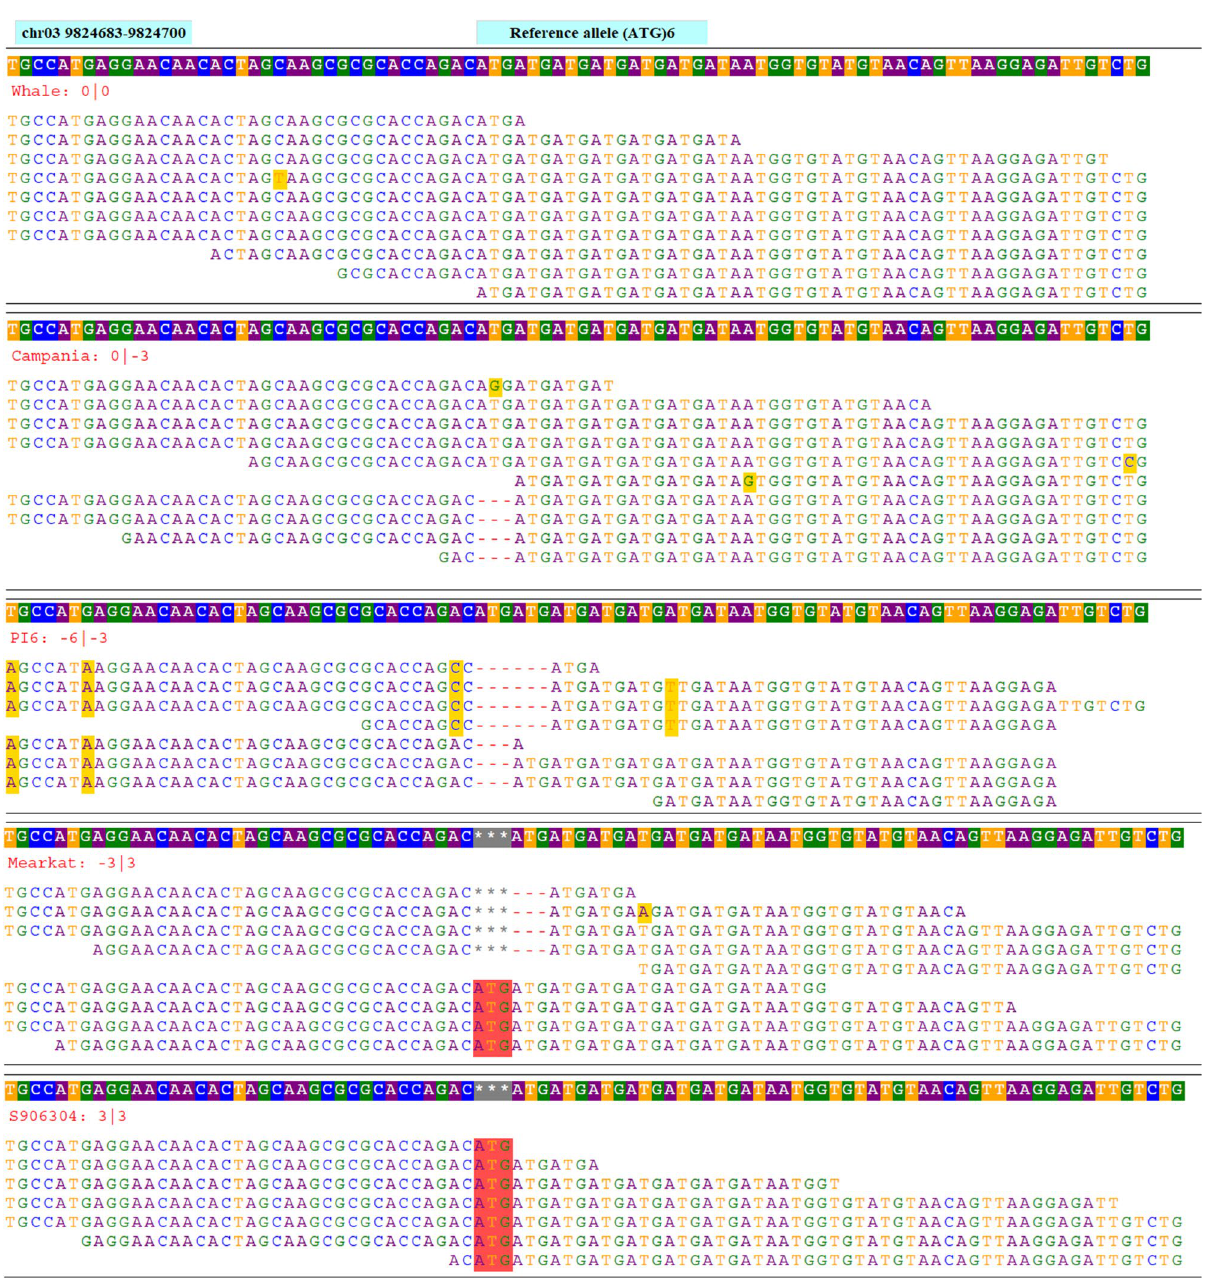
Figure 3. Genome sequences alignments of tri-repeat SSR loci chr03_3_9824683 comprised of ’ATG’ motif repeating for six times (ATG)6 and located on chromosome 3 at 9,824,683 bp in the reference genome. Genome sequences of multiple accessions were aligned to the reference genome and variation in the number of repeat units for the SSR repeat motif ’ATG’ among the accessions were recorded. The reference sequence containing SSR loci is displayed on the top row while the allele sizes of each accession are displayed on the second row and the aligned reads of each accession are presented on succeeding